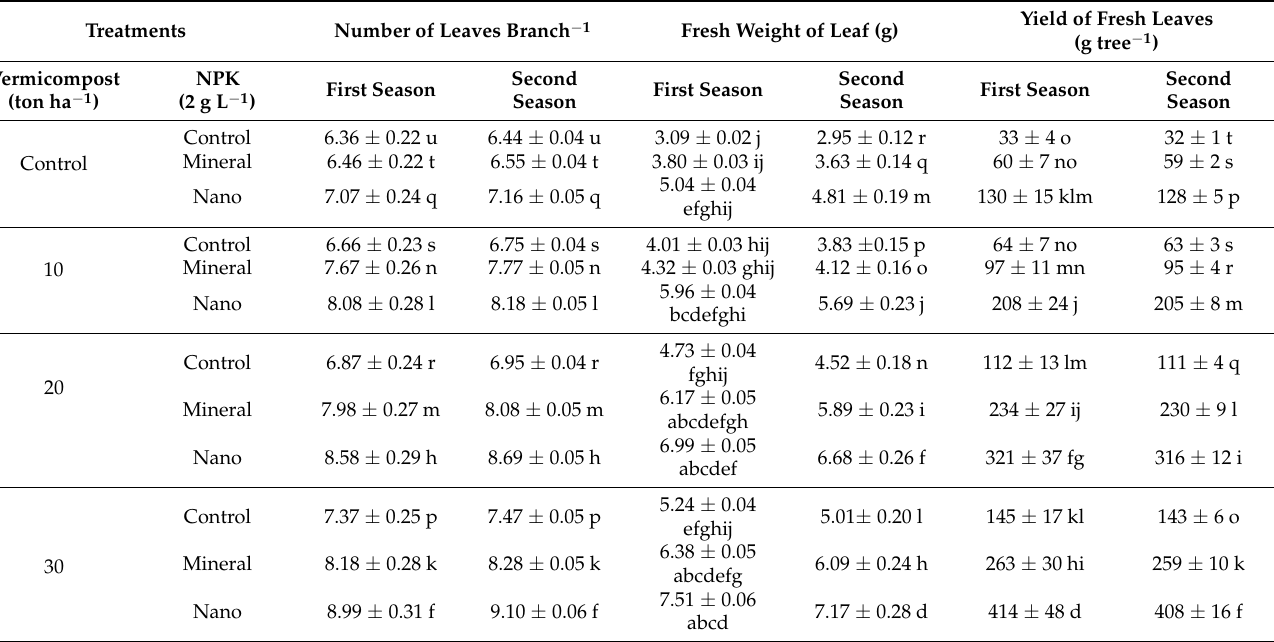
Table 2. The influence of combined treatments of vermicompost and NPK fertilization on the mean values of number of leaves per branch, fresh weight of leaf (g), and yield of fresh leaves (g tree − 1 ) of Moringa oleifera trees in the first and second